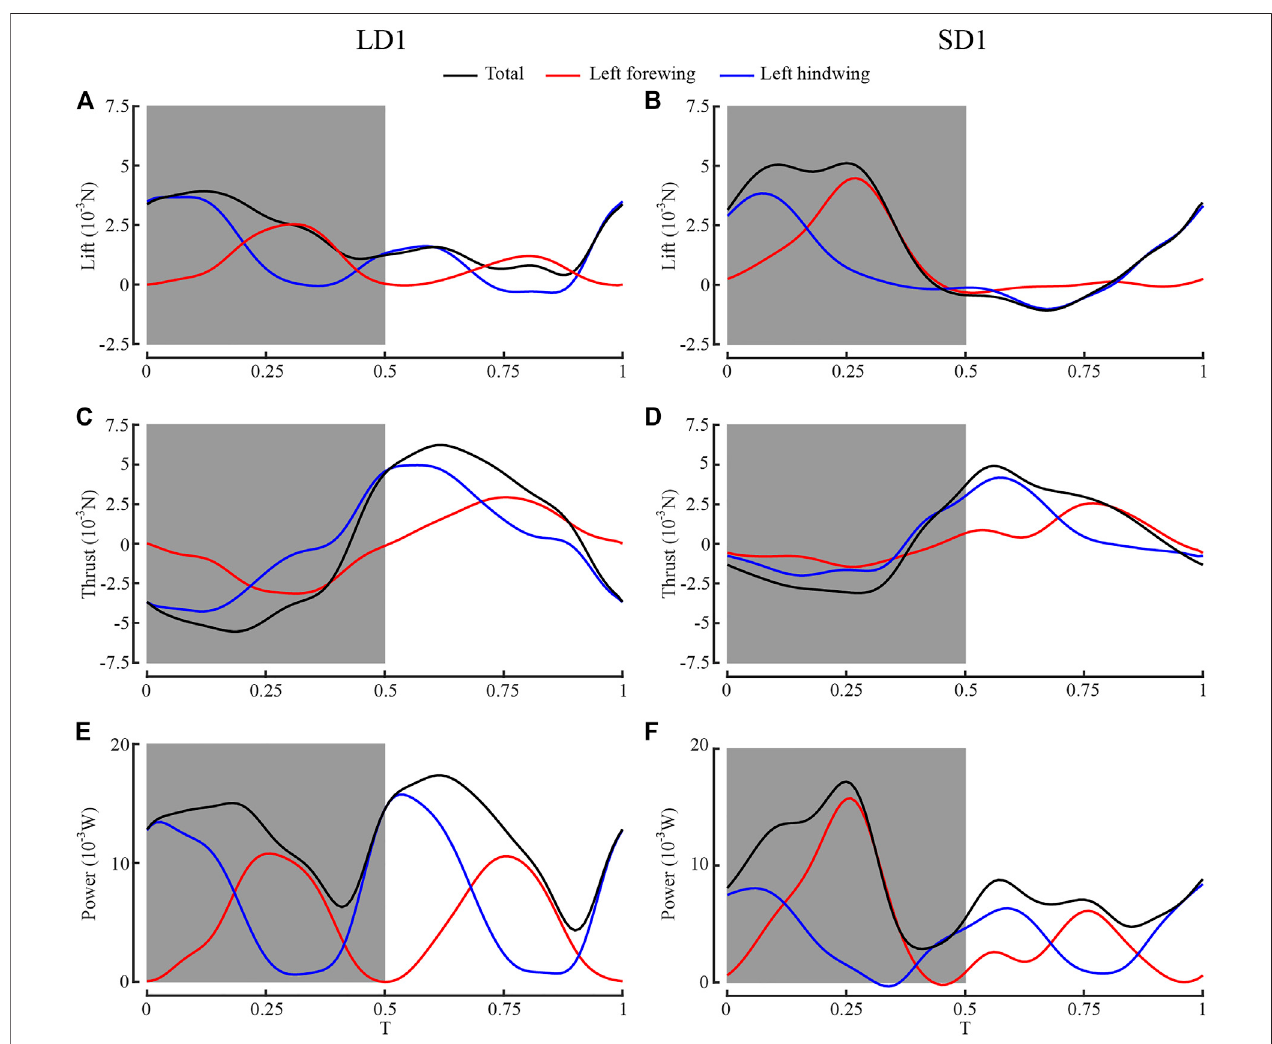
FIGURE 7 | Comparison of aerodynamic performance between left forewing, left hind wing, and both wings. (A) Lift of LD1; (B) lift of SD1; (C) thrust of LD1; (D) thrust of SD1; (E) power of LD1; (F) power of SD1.